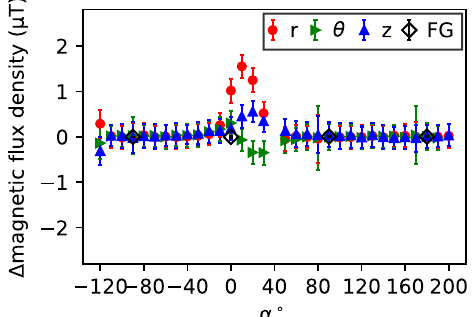
FIG. 10. Magnetic field distribution difference before and after several quenches. When the cavity was quenching, a magnetic field of − 18 μ T was applied along the z -direction.